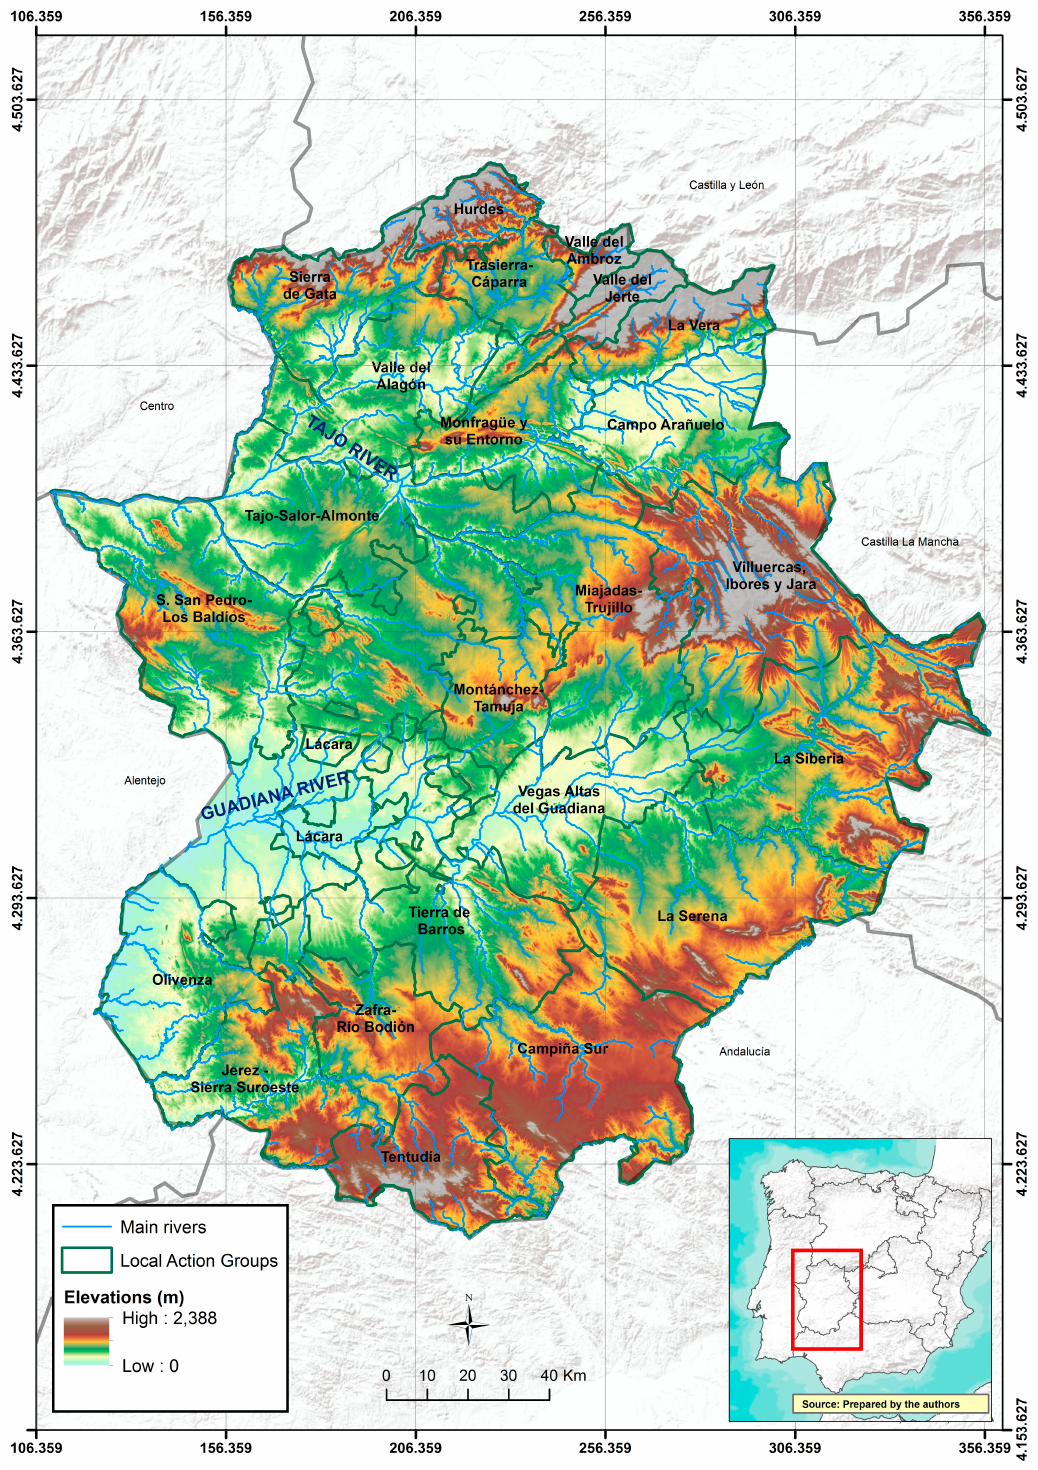
Figure 2. Digital Elevation Model of Study area of Extremadura (South Western Spain). Source: authors.